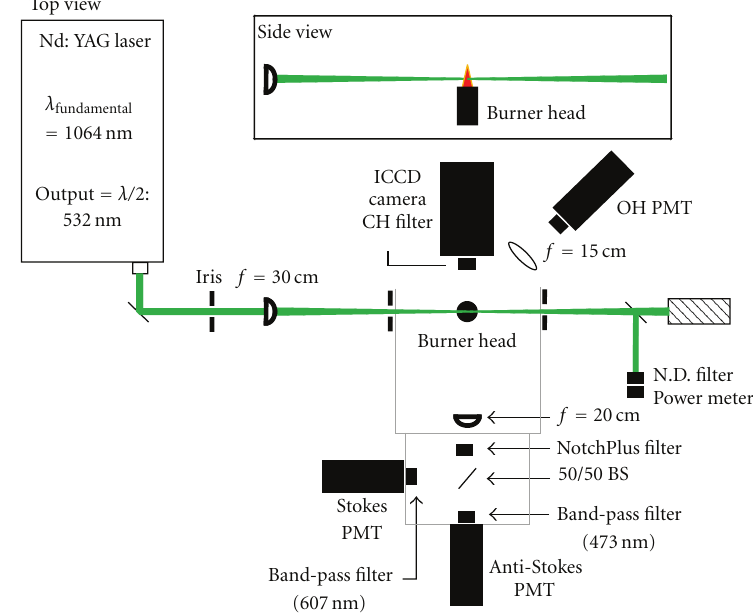
Figure 2: Laser diagnostic setup for spontaneous Raman scattering from N 2 along with simultaneous measurements of CH (A-X) chemiluminescence with ICCD images, and flame volume averaged OH (A-X) intensity with